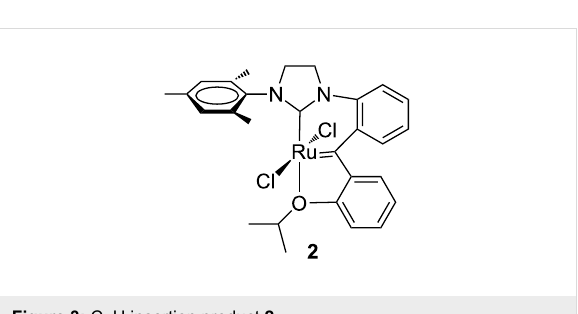
Figure 2: Grubbs ( 1a ) and Hoveyda-type ( 1b ) complexes with N -phenyl, N’ -mesityl NHCs.